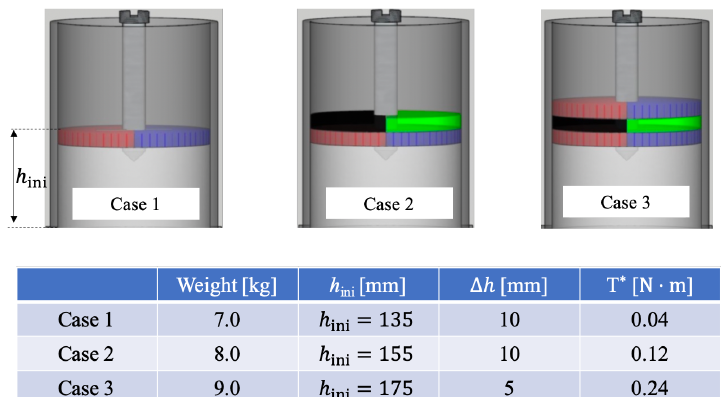
Figure 4. Above : Illustrations of the initial configurations of the three experiments for validation. Below : Measured quantities from the three experimental cases, where h ini stands for the initial surface height, ∆ h for the maximal increase of surface height after mixing, and T ∗ for the steady-sate torque.